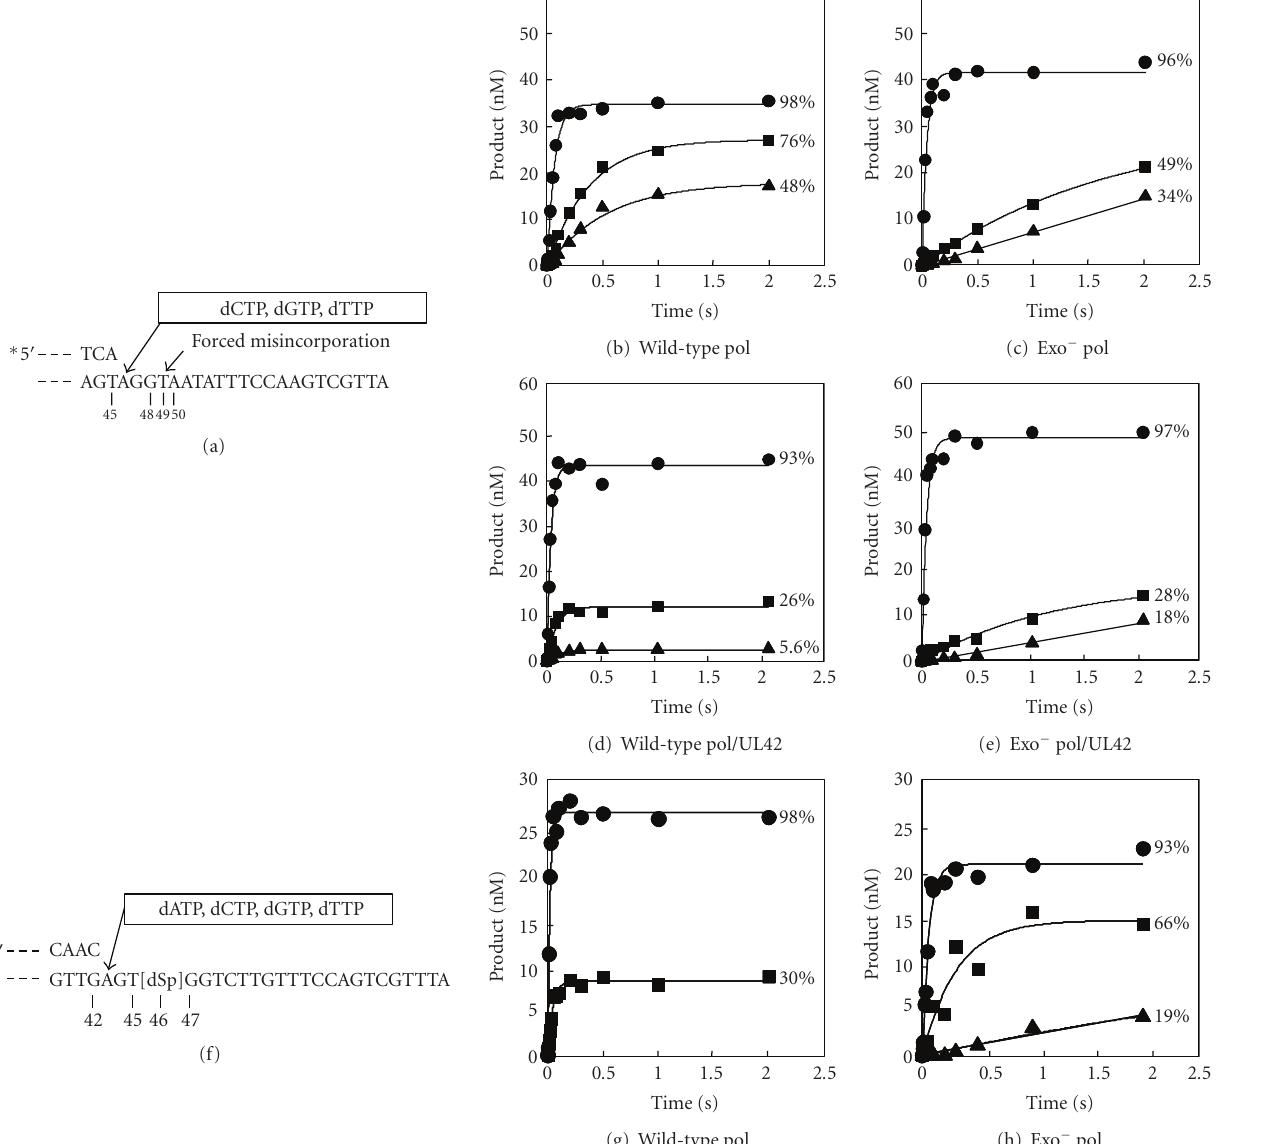
Figure 1: Running-start single-turnover kinetics for extension of mismatched or damaged P/Ts by HSV-1 DNA polymerase. Panels (a)– (e) represent forced misincorporation and extension reactions and are adapted from [75] whereas panels (f)–(h) show extension of AP- containing P/Ts and are adapted from [79]. (a) A partial sequence of the P/T (5 (cid:2) end-labeled 45nt primer annealed to 67nt template) is shown. The dNTPs added lacked dATP to force misincorporation opposite position 49 in reactions containing the wild-type pol (b), exo − pol (c), wild-type pol/UL42 (d), or exo − pol/UL42 (e).Reactions were performed with 50nM enzyme, 100nMP/T, and 250 μ M ofeach dNTP indicated and single-turnover conditions were ensured by the addition of nonradioactive activated calf-thymus DNA trap (500 μ g/ml) at the time of initiation. Reactions were terminated by the addition of EDTA, products were separated on denaturing polyacrylamide gels, gels were exposed to storage phosphor screens, and bands were quantified as previously described [75, 79]. (b)–(e) show plots of the concentration of ), 49 ( ), or 50 ( ) nt in length. Except as indicated, the data were fit to the burst equation products formed greater than or equal to 48 ( (cid:0) (cid:2) (cid:0) [extension product] = A (1 − e − kt ), where A is the burst amplitude, k is the observed rate constant, and t is the reaction time. The plots for formation of 50nt product by the exo − pol or exo − pol/UL42 were produced by fitting the data to a linear function. The percentages next to each curve represent the amounts of primer ≥ to that length compared to the amount of P/T actively engaged by the respective polymerases (i.e., that were extended by at least 1nt). (f) A partial sequence of the P/T is shown. A dSpacer (dSp) was placed at position 46 from the 3 (cid:2) end of the template to mimic an abasic site. Reactions were performed as indicated above except that all four dNTPs were included for extension by wild-type pol (g) or exo − pol (h). Products representing primers extended to position 45 located 1nt upstream ( − 1) of the AP site and beyond ( ), products extended to the AP site and beyond ( ), and products that were extended 1 or more nucleotides past the AP (cid:0) (cid:0) ) are shown. The data in the plots were fit to the burst equation or to a linear function as indicated for plots (b)–(e). The numbers to site ( (cid:2) the right of the curves represent the percentage of primers extended at least to this site compared to the number that were actively engaged by the respective